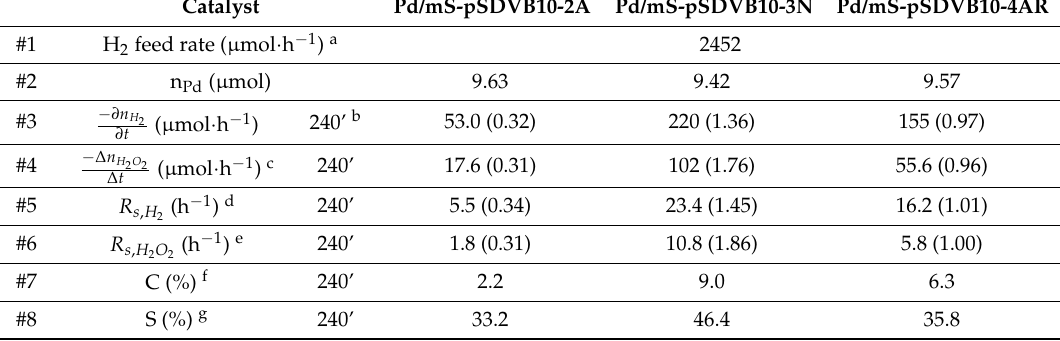
Table 5. Apparent and specific rates (values relative to the fresh catalyst in parentheses) of H 2 consumption and H 2 O 2 formation and the respective conversions and selectivities over aged Pd/mS-pSDVB10